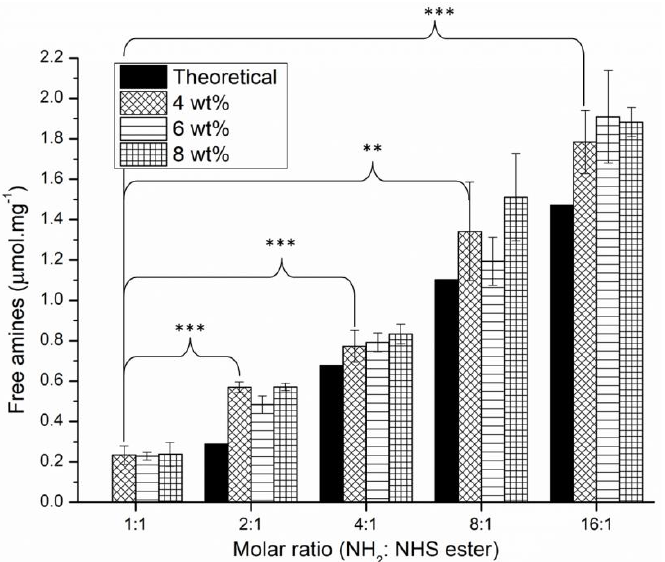
Figure 5. Concentration of free amines in the hydrogels compared to the calculated theoretical concentration when assuming complete reaction between the free amines and NHS esters. The effect of the molar ratio was found to be statistically significant as determined from Student’s t -tests. This is indicated by the double asterisks (**) for p < 0.01 and the triple asterisks (***) for p < 0.001 for the 4 wt% hydrogels. The effect of hydrogel concentration on the concentration of free amines was not statistically significant.